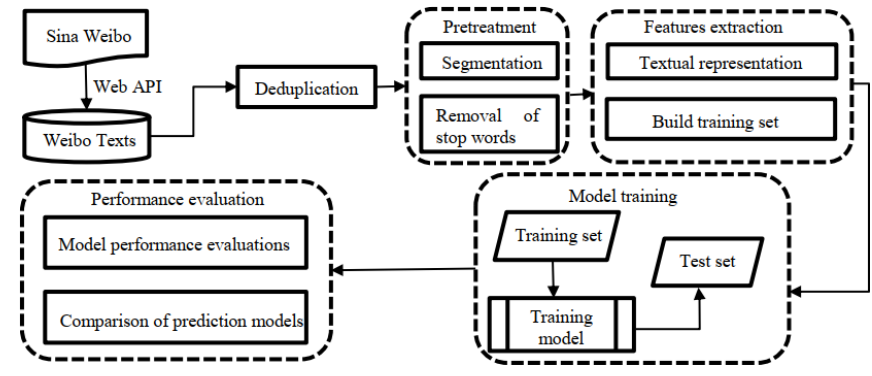
Figure 1. Illustrative diagram of our method